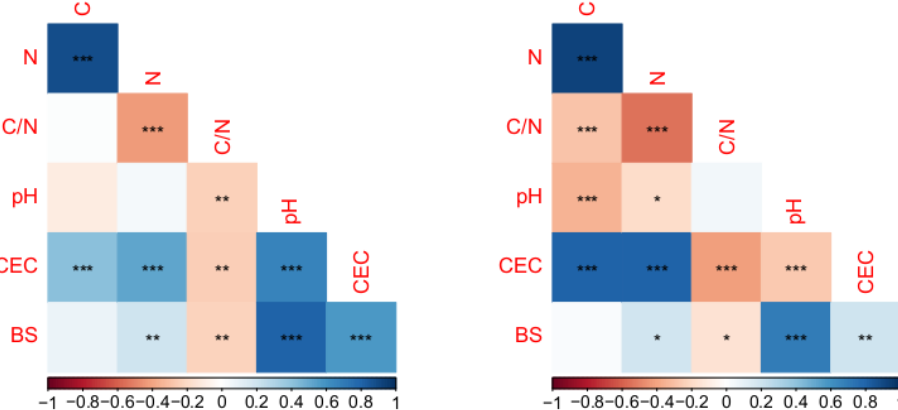
Figure 4. Significance of Pearsons correlation coefficients between investigated soil properties for Oh ( left ) and Ah ( right ) horizon (* , ** and *** indicates a p -value < 0.05, < 0.01 and < 0.001,